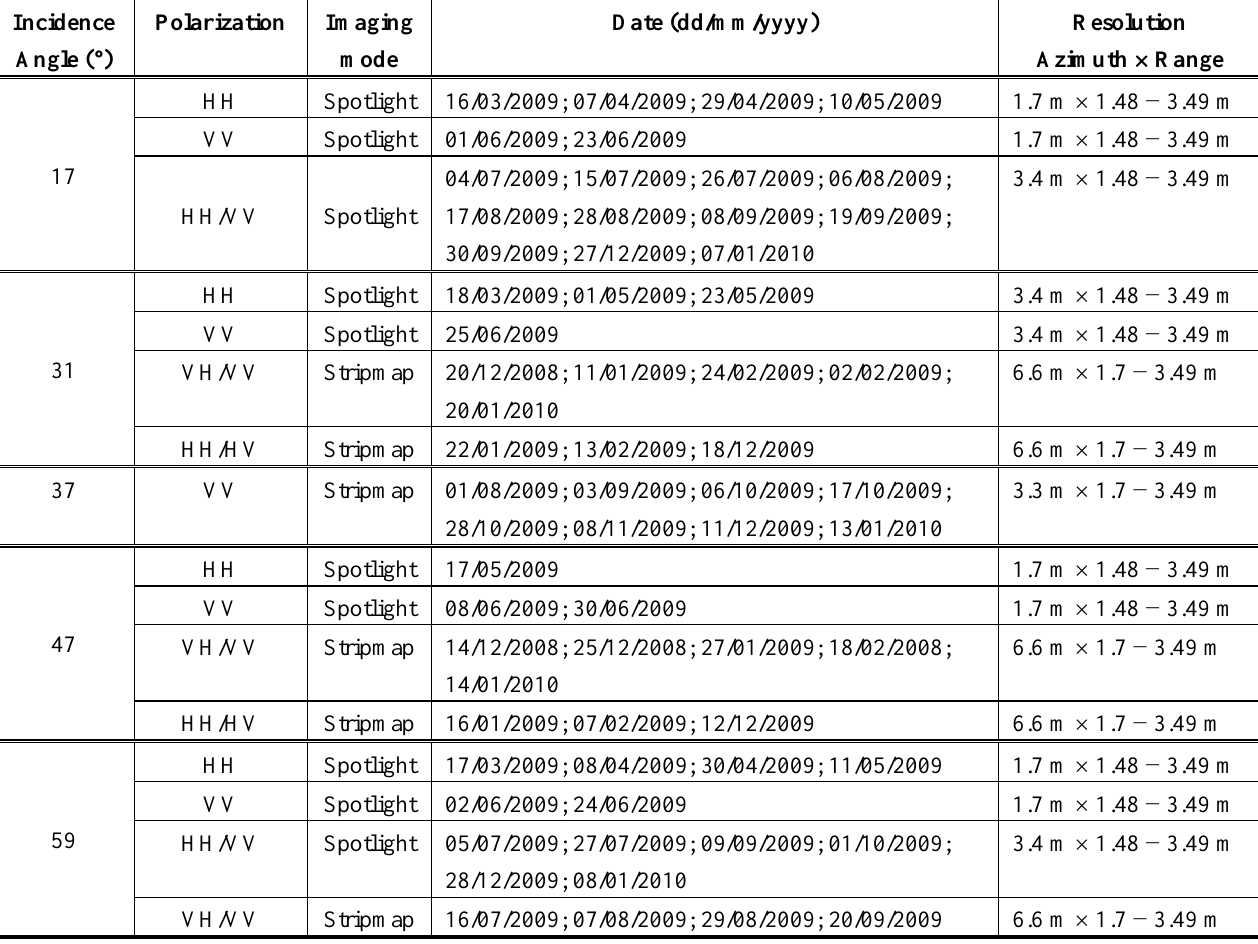
Table 1. Main characteristics of TerraSAR-X images used in this